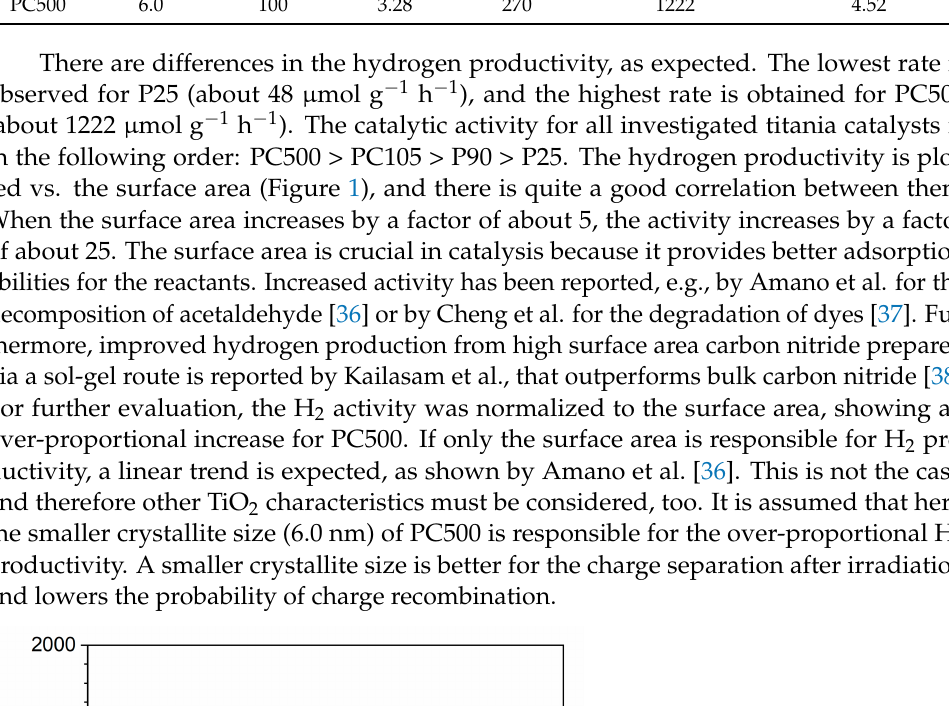
= 0.56 g · L − 1 , 300 W Xe full spectrum, 2